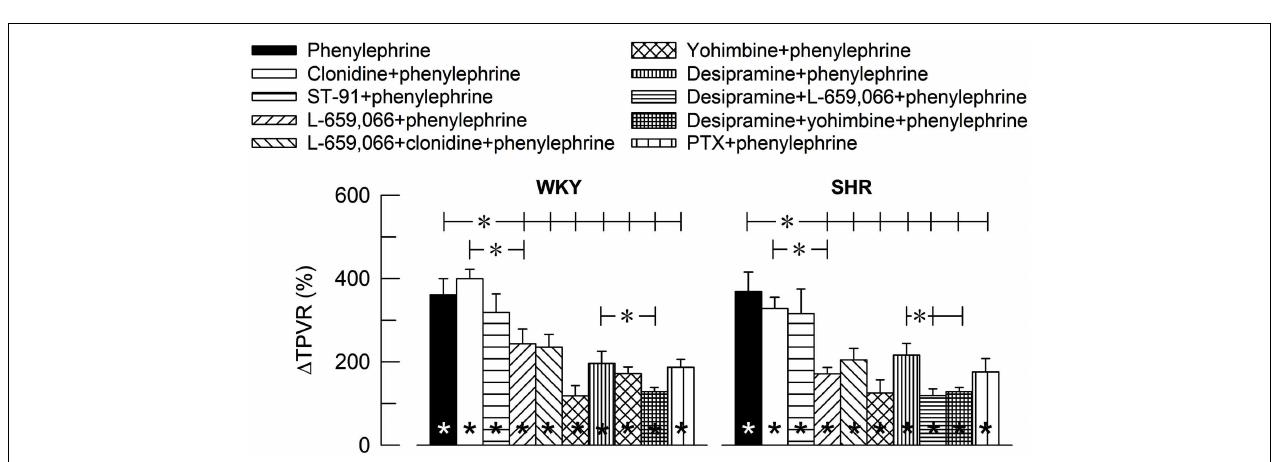
FIGURE 2 |The influence of α 2 AR on theTPVR-peak-response to the α 1 AR agonist phenylephrine. The rats were pre-treated as indicated by symbol legends.TPVR prior to phenylephrine is shown in Table 2 . Within columns; significant responses. *In brackets; significant group differences. P ≤ 0.005; * P ≤